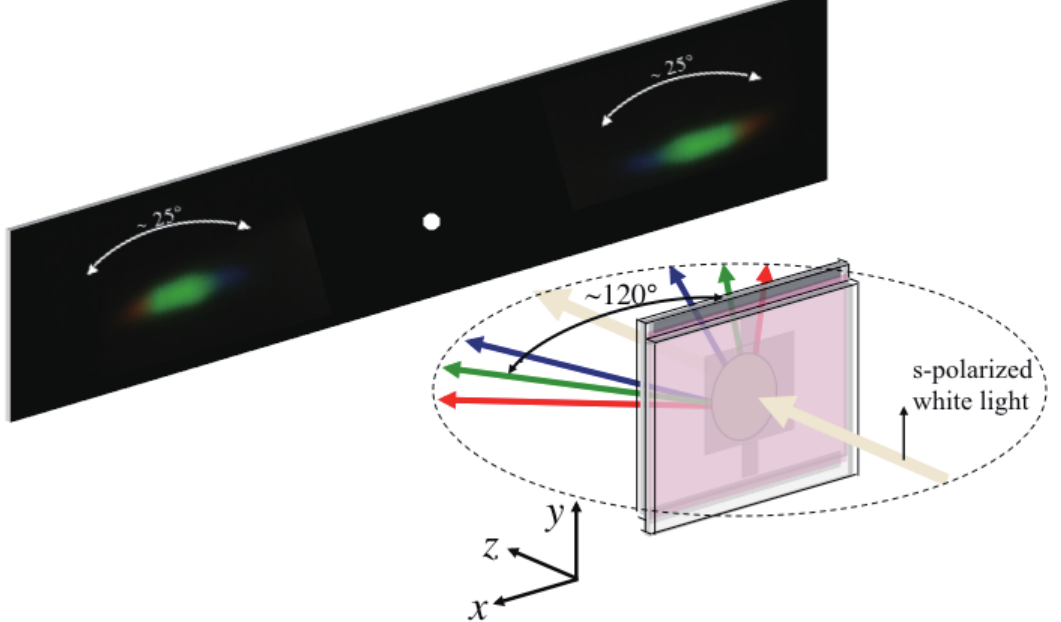
Figure 12. Observed wavelength dispersion pattern from an HPDLC film recorded by three s-polarized plane-wave interference holographic polymerization and readout by normally incident s-polarized white light in the absence of E ex